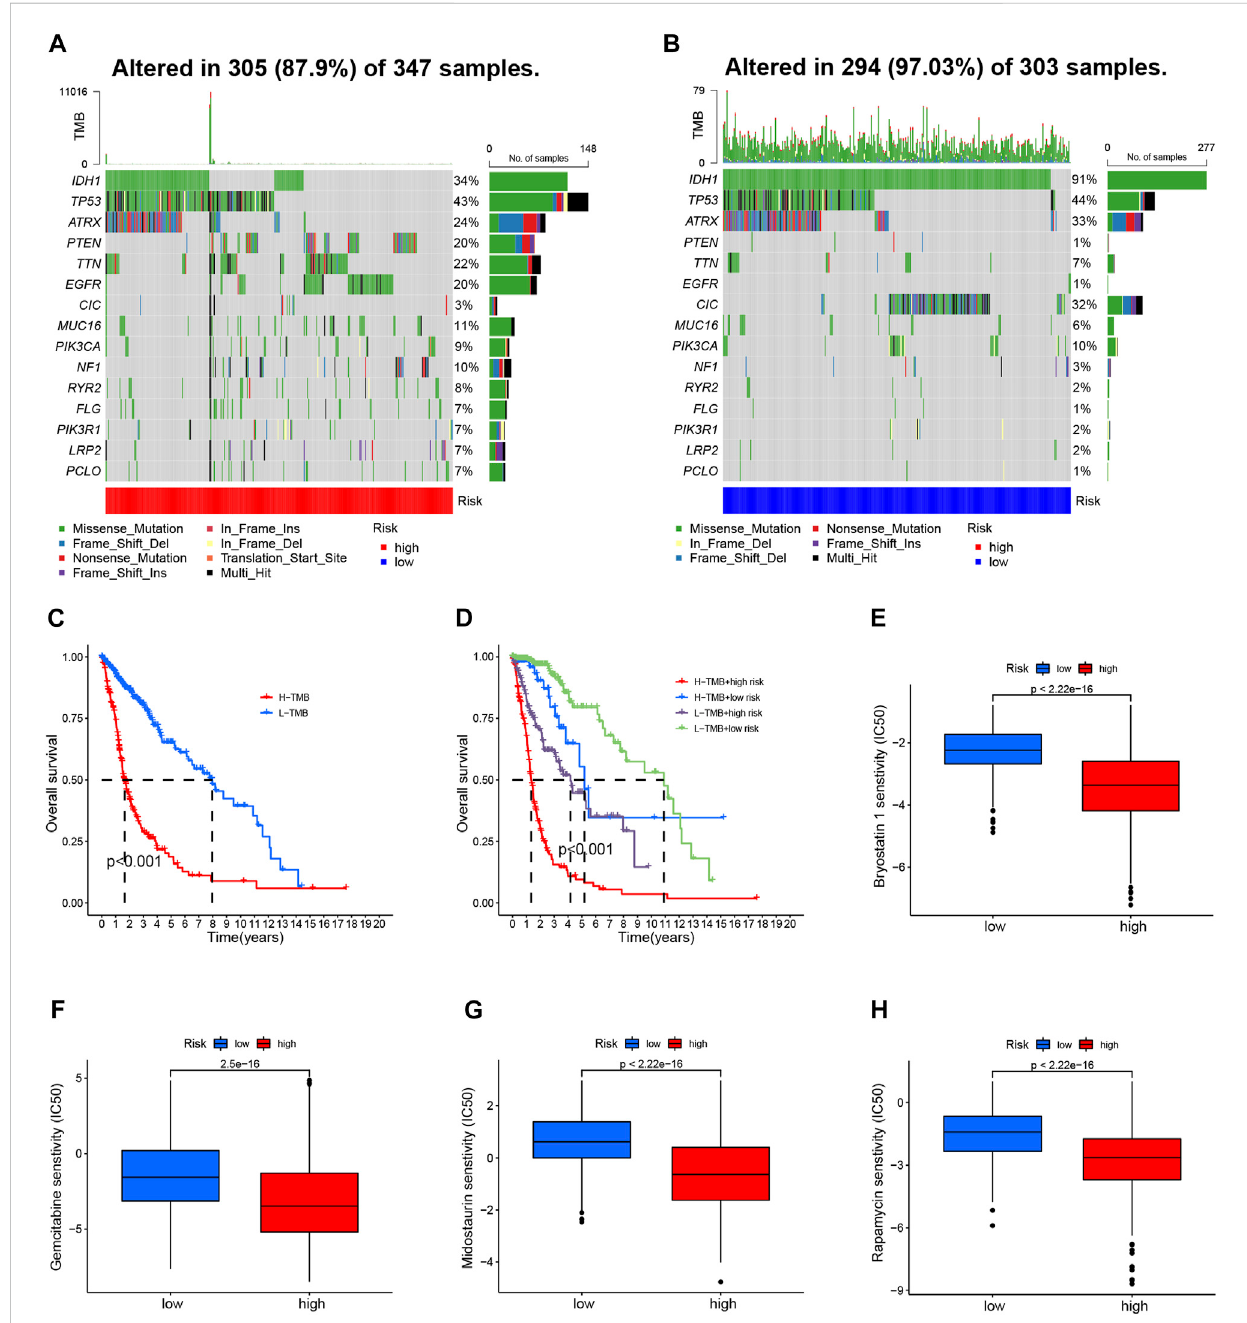
FIGURE 7 TMB analyses and drug sensitivity between high- and low-risk groups (A, B) Waterfall plots showing the mutational information for the genes with high mutation frequencies in the high- (A) and low- (B) risk groups (C) . Kaplan – Meier curve for OS of patients with glioma in high- and low-TMB groups ( p < 0.001) (D) . Kaplan – Meier curvefor OS ofpatients with gliomabased ontheTMB and therisksignatureofCRLs (E – H) .The sensitivityofdrugs suchas bryostatin 1 (E) , gemcitabine (F) , midostaurin (G) , and rapamycin (H) , for the treatment of glioma, based on the IC50. CRL, cuproptosis-related lncRNA; OS, overall survival; TMB, tumor mutation